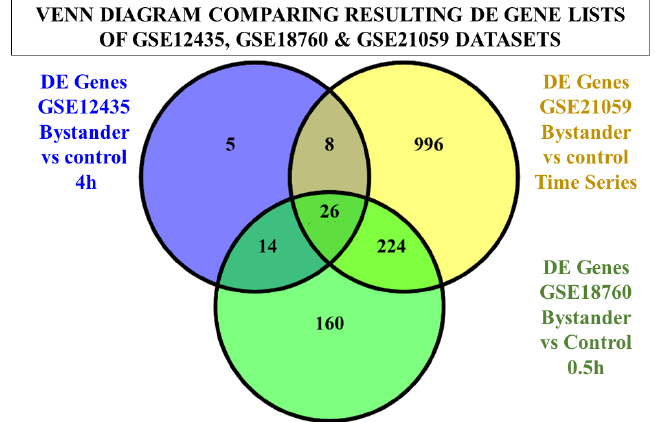
Figure 1. Venn diagram of DE genes lists regarding the GSE12435, GSE18760, and GSE21059 datasets for the comparisons of bystander vs. control samples. The comparison resulted in 26 common DE genes.